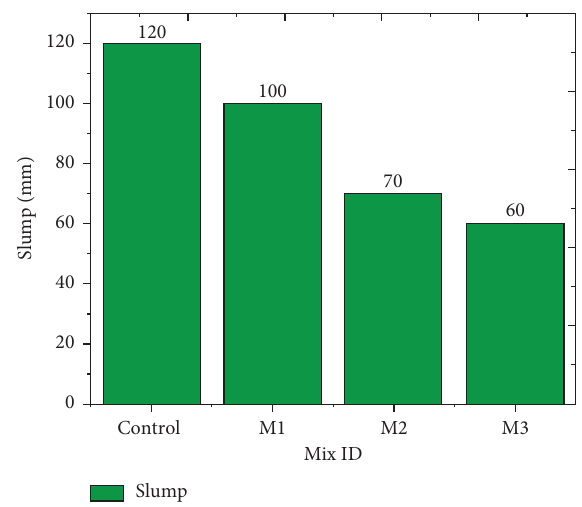
Figure 8: Slump test values of concrete